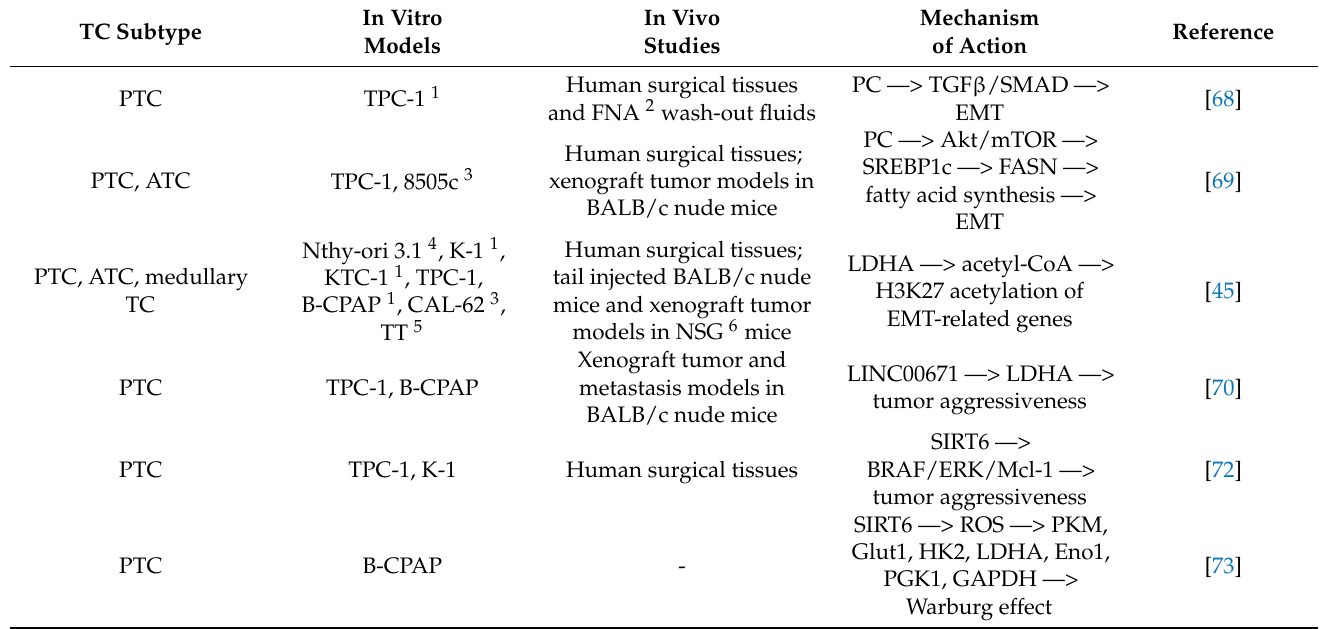
Table 1. Studies linking metabolic reprogramming to EMT in thyroid cancer